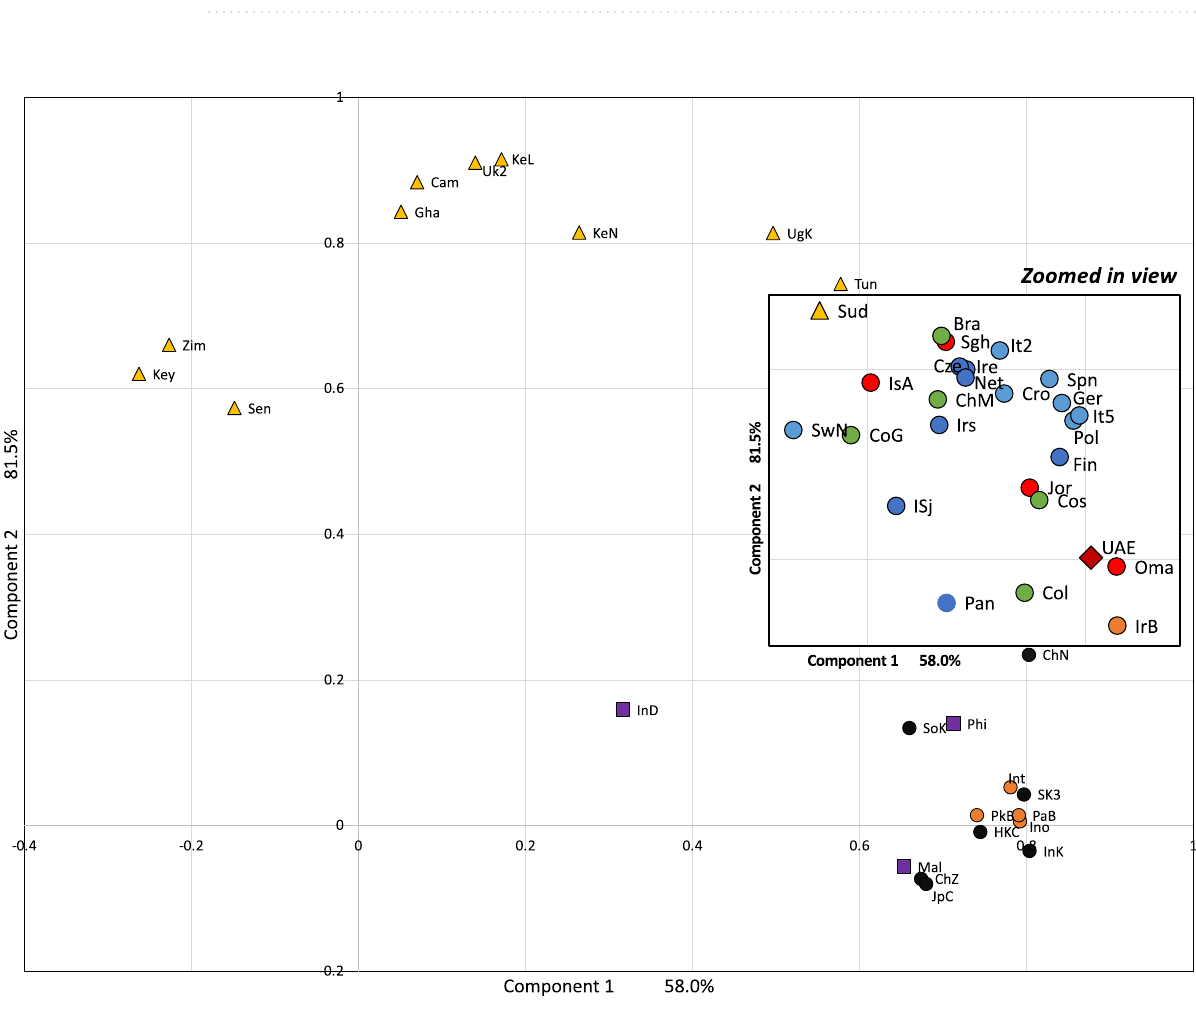
Figure 1. Principal Component Analysis (PCA) for 50 populations (including the UAE cohort reported herein) from different world regions calculated using HLA-A, -B, and -DRB1 loci. The first component is explained by 58.0% of the variance, while the second component is described by 81.5% of the total variance. The Sub-Sharan Africa populations are denoted in yellow triangles, while European populations are represented by light blue dots; the Middle Easter populations are presented in red dots; the Oceania populations are in purple squares; the South Asian populations are indicated by orange dots; black dots were assigned to East Asian populations and green dots to South American groups. For the complete PCA plot and description of datasets used and their abbreviations, refer to Table